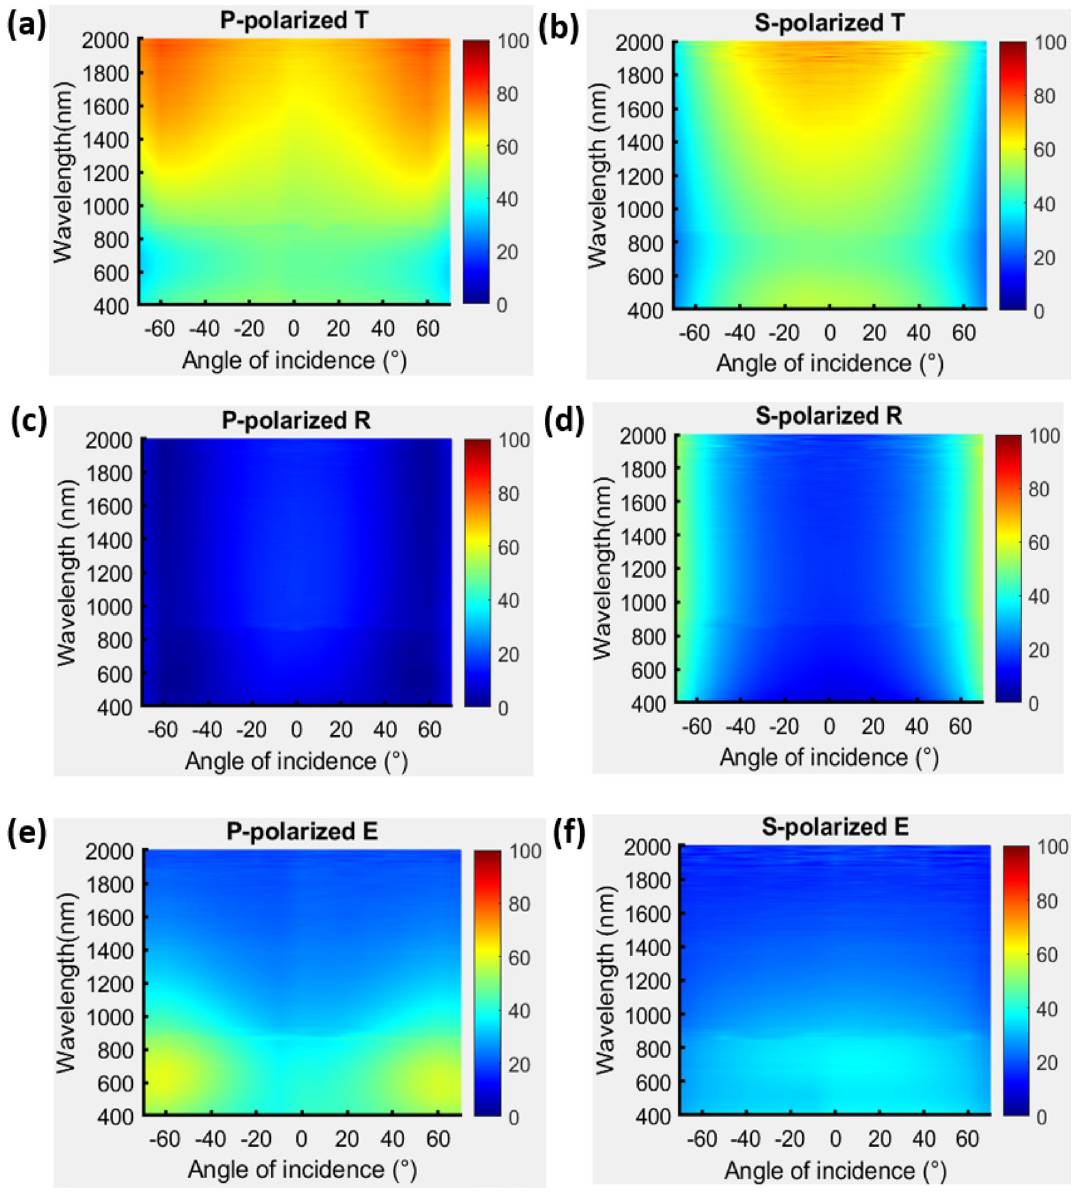
Figure 4. P-polarized and s-polarized transmittance ( a , b ), reflectance ( c , d ) and extinctance ( e , f ) spectra measured at ϕ = 90 ◦ that incident plane is perpendicular to deposition deposited on a BK7 substrate. The top-view and cross-sectional SEM images are shown in Fig. 5b,c, respectively. The uniform TiN film was used to reduce the transmission and reflect light back to the nanorods to dissipate its energy again. The average length, rod width and tilt angle of the upper NRA were 127.8 nm, 49.7 nm and 37.4 ◦ , respectively. The average length, rod width and tilt angle β of the bottom NRA were 152.3 nm, 33.1 nm and 33.6 ◦ , respectively. The total thickness of the TiN structure was 232.3 nm. Figure 5a also schematically depicts the orientations of the nanorods with respect to the system coordinates. The s-polarized and p-polarized trans- mittance, reflectance and extinctance spectra were measured with the incident plane coincident with the x–y plane. The p-polarized extinctance was larger than 90% at angles of incidence from 0 ◦ to − 60 ◦ and wavelengths from (cid:31) = 400 nm to (cid:31) = 861 nm . For wavelengths of greater than 1400 nm, a high extinctance of over 78.9% obtained at angles of incidence between − 50 ◦ and 50 ◦ . For wavelengths from 900 to 1300 nm, the reflectance